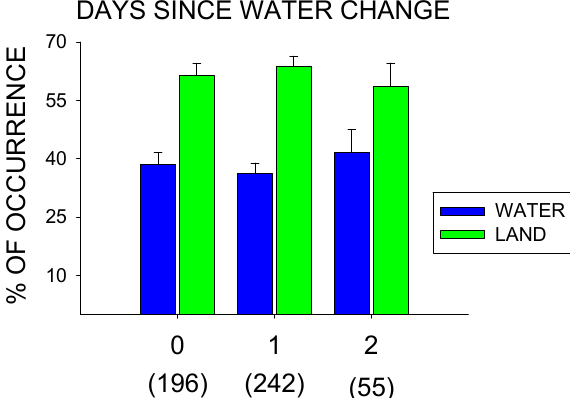
Figure 3. Percentage of water vs. land use (with standard error of the mean bars [SE]) based on the days since a water change (0, 1, or 2 days) for the total observations ( n = 493) during the entire study (January–July). Number of observations for each condition are listed in the parentheses below each condition.